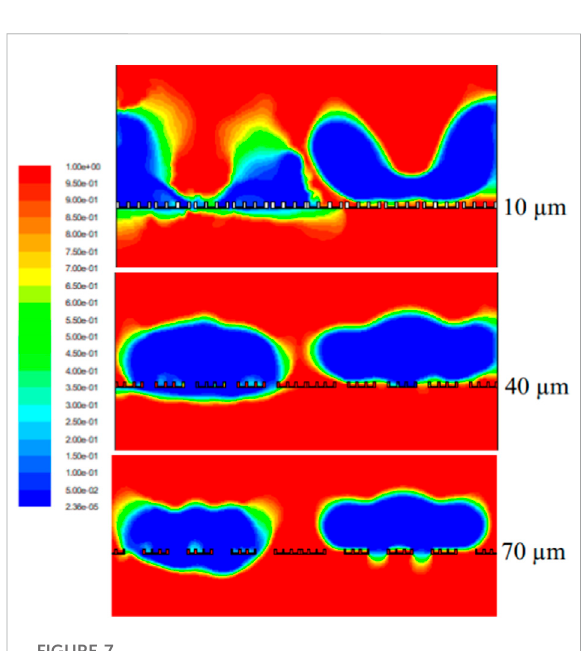
FIGURE 7 Cloud picture of the oil – water volume fraction under the copper net mesh size of 10, 40, and 70 µm.